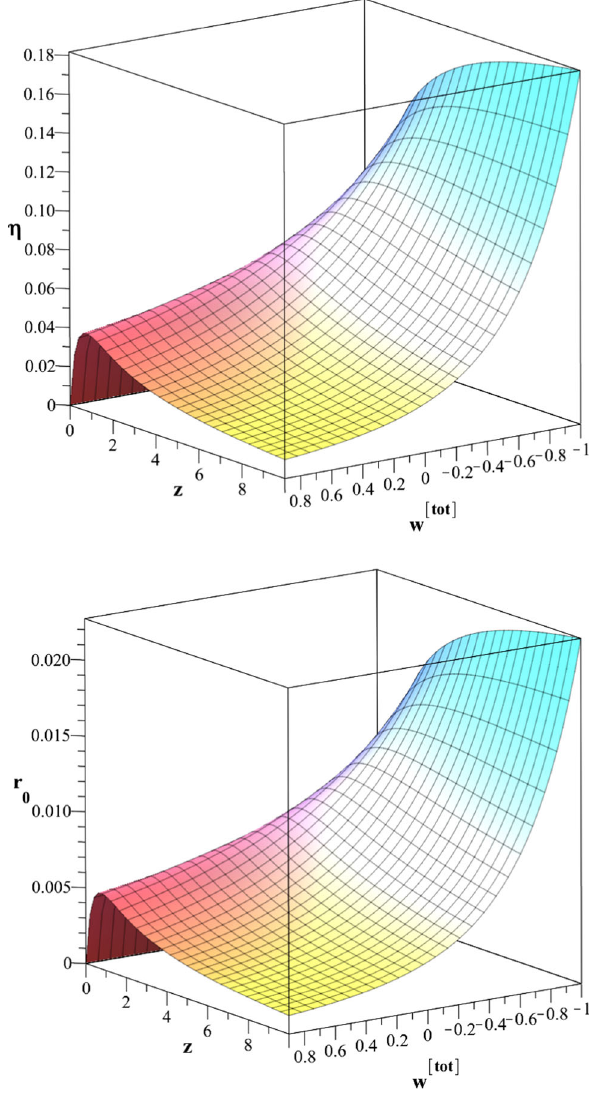
Fig. 2 The behavior of the deviation vector (the top diagram) and the observerarea-distance(thebottomdiagram)aredepictedwithrespectto theredshiftfornullvectorfieldswiththeinitialconditions η( z ) | z = 0 = 0, d η( z )/ dz | z = 0 = 1 and the parametric values H 0 (cid:7) 67 . 6